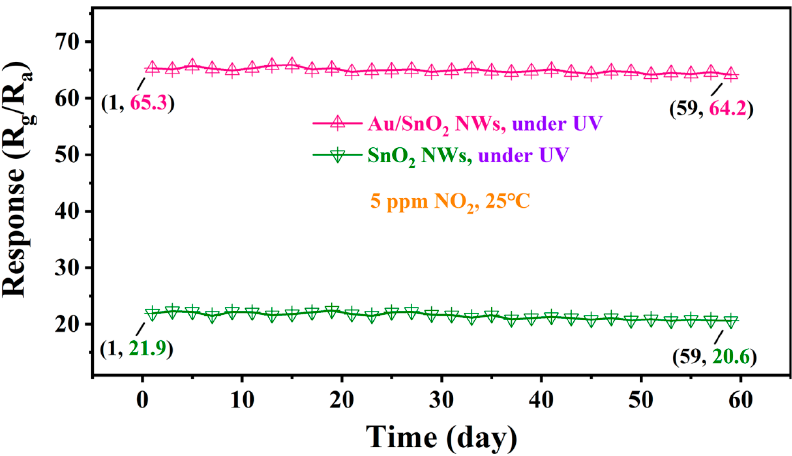
Figure 10. Long-term stability tests of sensors based on SnO 2 and Au/SnO 2 NWs to 5 ppm NO 2 at RT under UV irradiation (0.42 mW/cm 2 ).